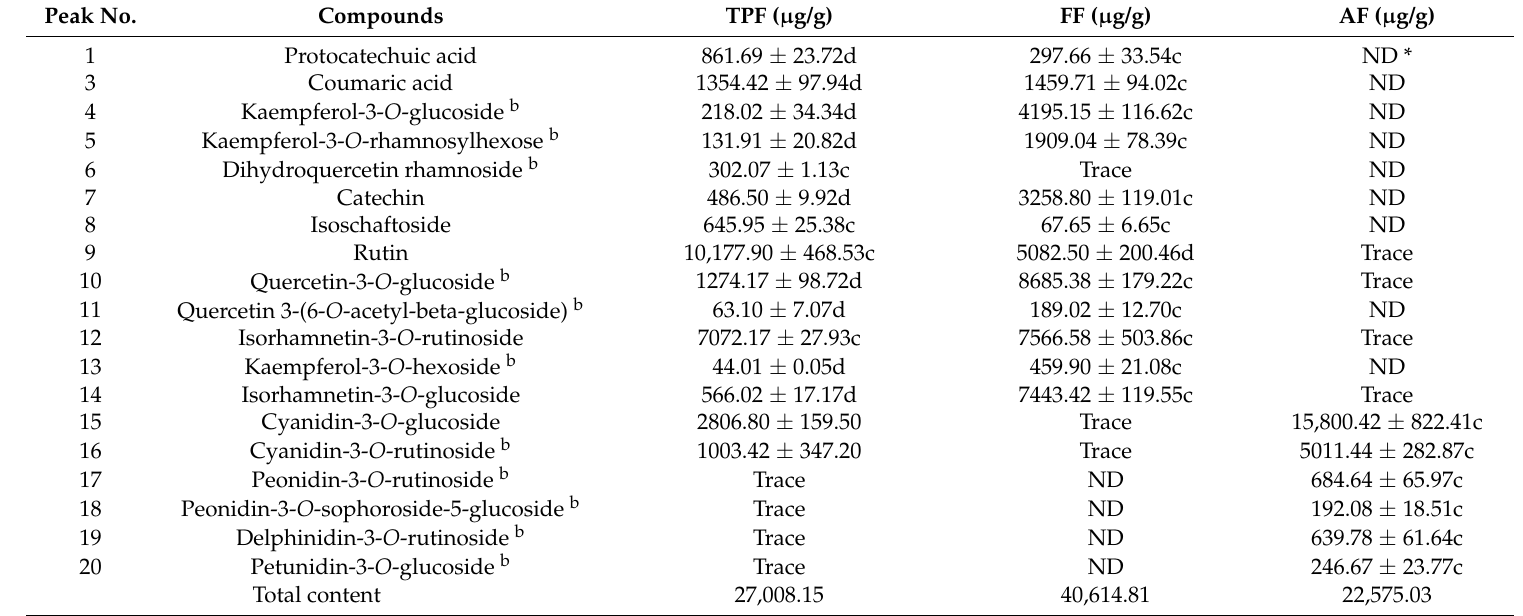
Table 2. Quantitative result of the identified phenolics in the different phenolic fractions (TPF, FF, and AF) of P. utilis fruits by UPLC-ESI-HRMS/MS a . Peak